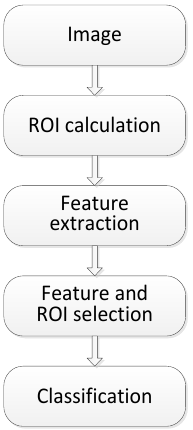
Figure 1. The steps of operation of the system for automatic recognition of